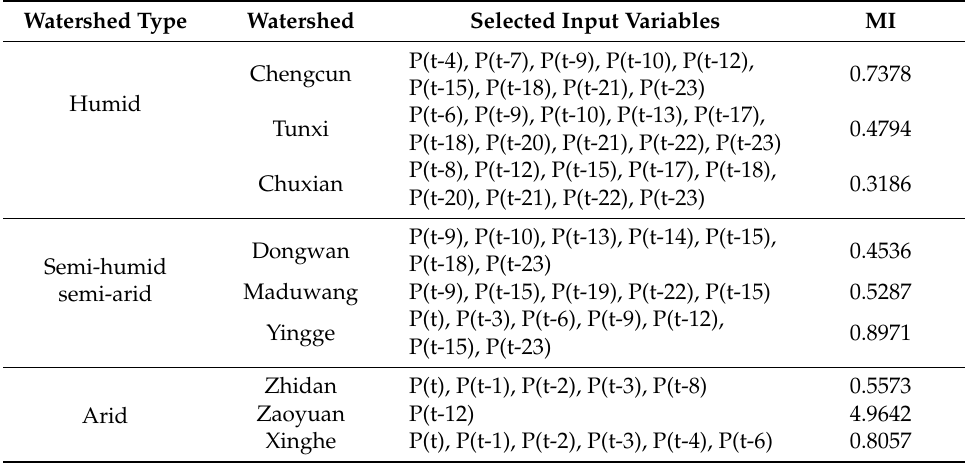
Table 2. Selected input variables and MI of the 9 studied